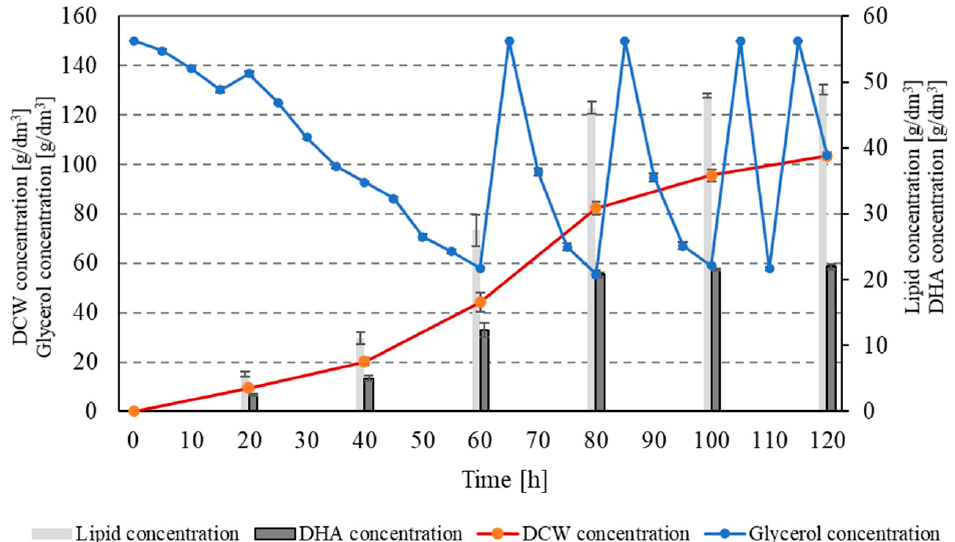
Figure 2. Changes in DCW concentration, lipid concentration, and DHA concentration in Schizochytrium sp. biomass and changes in glycerol concentration in the culture medium during the fed-batch culture.